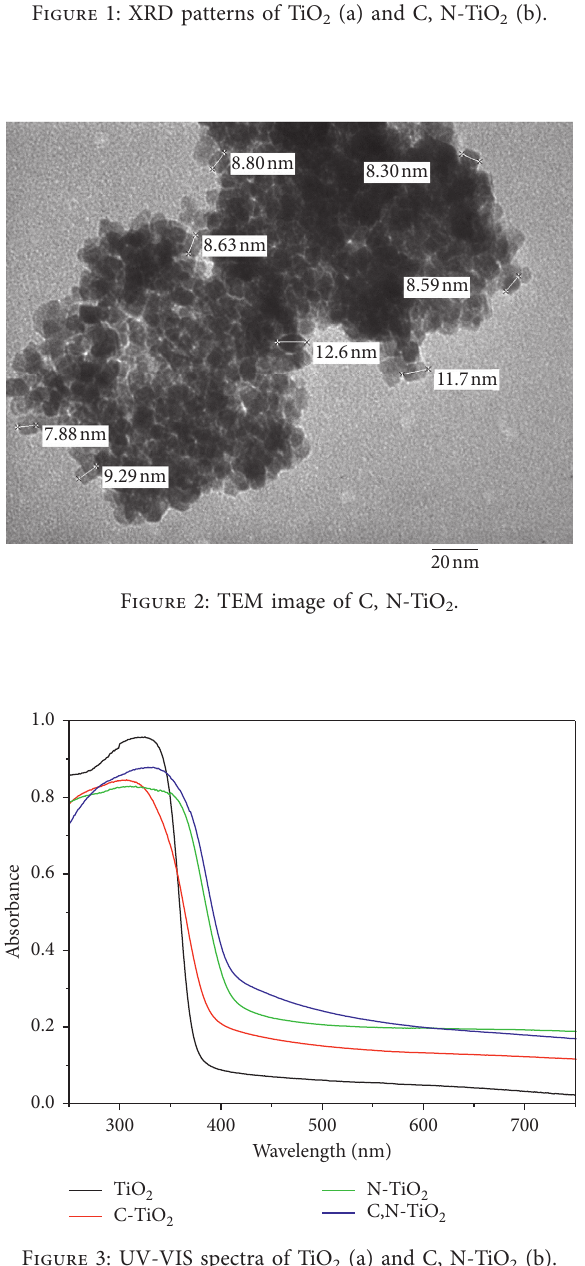
2 (a) and C, N-TiO 2 (b).